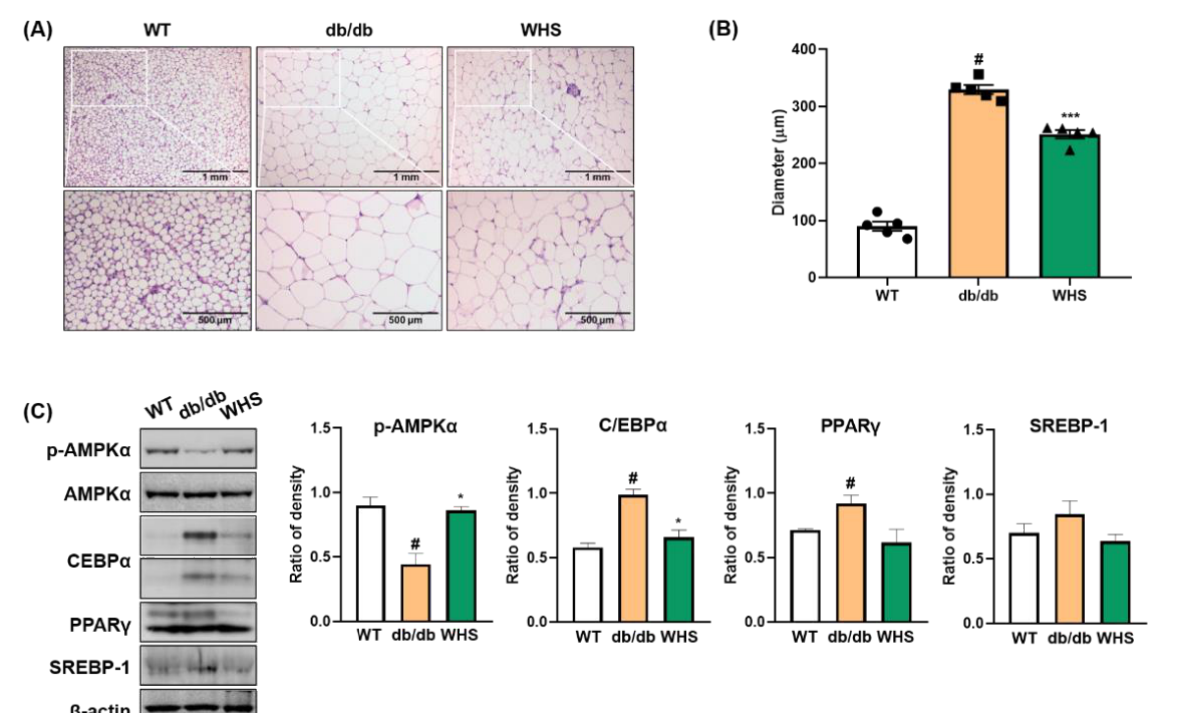
Figure 4. Effect of WHS on adipogenic factors in the subcutaneous fat of db/db mice. ( A ) Representative images of H&E- stained subcutaneous fat, ( B ) Average of adipocyte diameter. ( C ) Total protein was extracted from subcutaneous fat and western blot analysis was performed to examine the activation of AMPK and the expression of C/EBPα, PPARγ, and SREBP-1. Values are expressed as the mean ± SEM. # p < 0.05 vs. WT control group; * p < 0.05 and *** p < 0.001 vs. db/db control group.